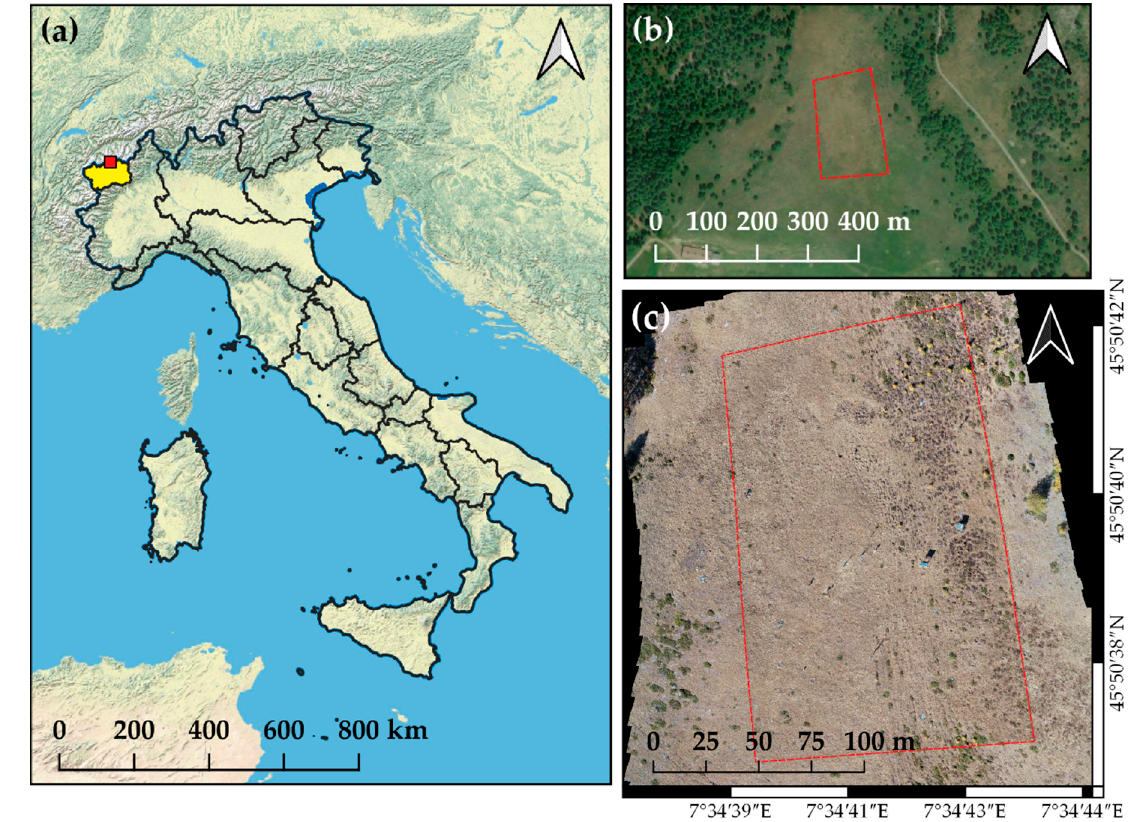
Figure 1. Study area: ( a ) ESRI physical map of Italy with the red dot highlighting the location of the study area in the Aosta Valley region (yellow); ( b ) ESRI satellite image of the grassland with surrounding larch forest; ( c ) portion of the area covered by drone that was used for classification (coordinate system: EPSG:4326–WGS84).